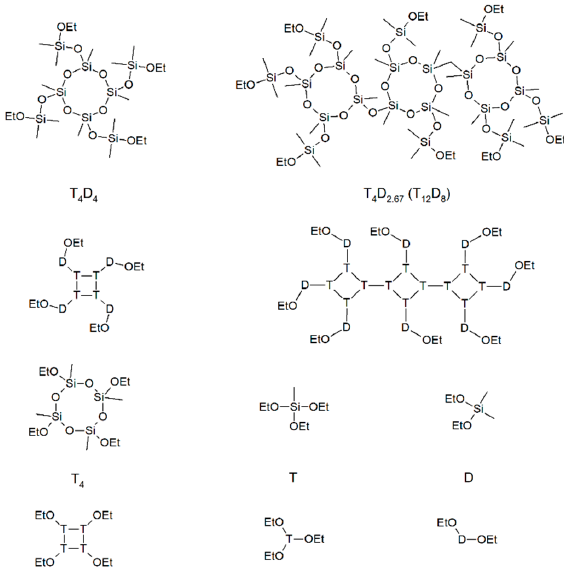
Figure 1. Molecular formulas (denoted at the top) and structural unit compositions (depicted below each molecular formula) of the target macromonomer (T 4 D 4 ), one of the isomers of the obtained macromonomer (T 4 D 2.67 ), and other monomers used—2,4,6,8-tetraethoxy-2,4,6,8- tetramethylcyclotetrasiloxane (T 4 ), diethoxydimethylsilane (D), and triethoxymethylsilane